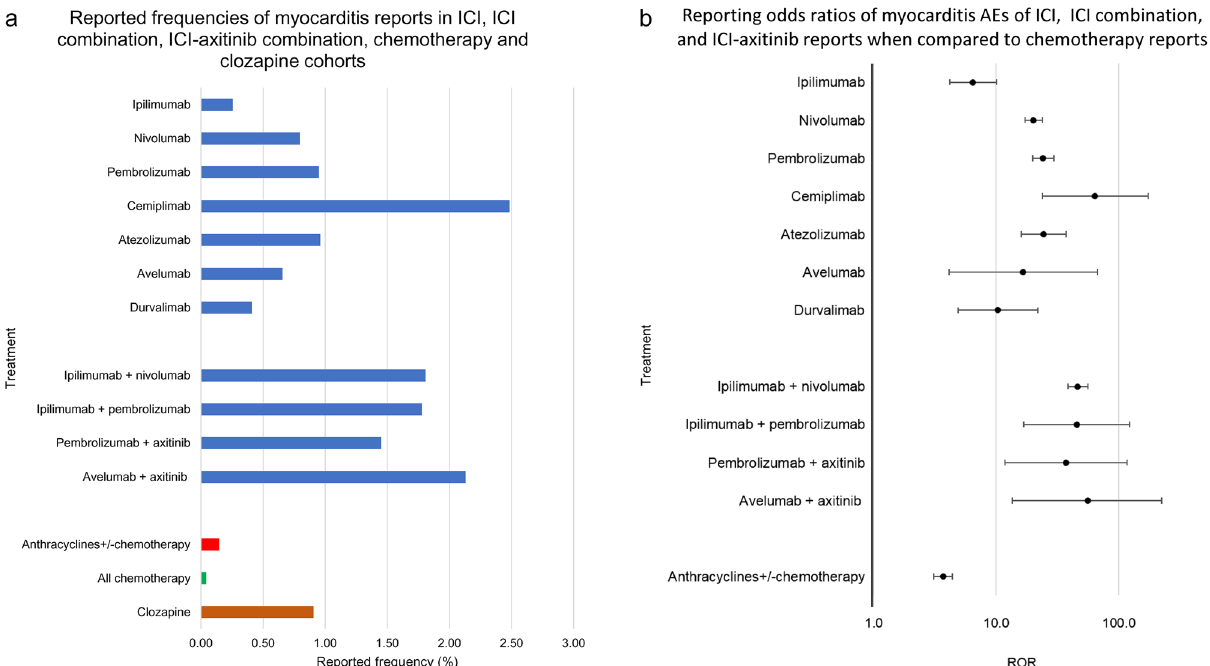
Figure 5. ( a ) Reported frequencies of myocarditis events for patients administered monotherapy: ipilimumab (n = 8267), nivolumab (n = 27,149), pembrolizumab (n = 13,476), cemiplimab (n = 161), atezolizumab (n = 2397), avelumab (n = 305), and durvalumab (n = 1710), ipilimumab + nivolumab (n = 7970), ipilimumab + pembrolizumab (n = 225), pembrolizumab + axitinib (n = 207), avelumab + axitinib (n = 94), anthracyclines with or without chemotherapy (n = 134,001), chemotherapy and chemotherapy combinations, excluding ICIs and anthracyclines (n = 1,065,158), clozapine (n = 50,558. ( b ) Reporting odds ratios were calculated comparing reported frequencies of myocarditis reports in ICI monotherapy, ICI combination and ICI with axitinib cohorts to myocarditis frequencies in chemotherapy cohorts. Anthracyclines ± chemotherapy cohort used as a positive